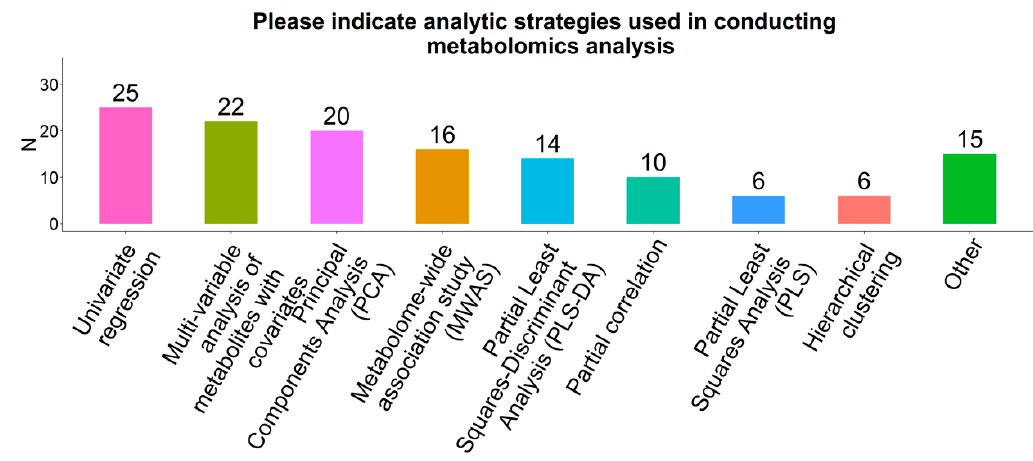
Figure 4. Analytic strategies employed for metabolomics data among participating COMETS cohorts.